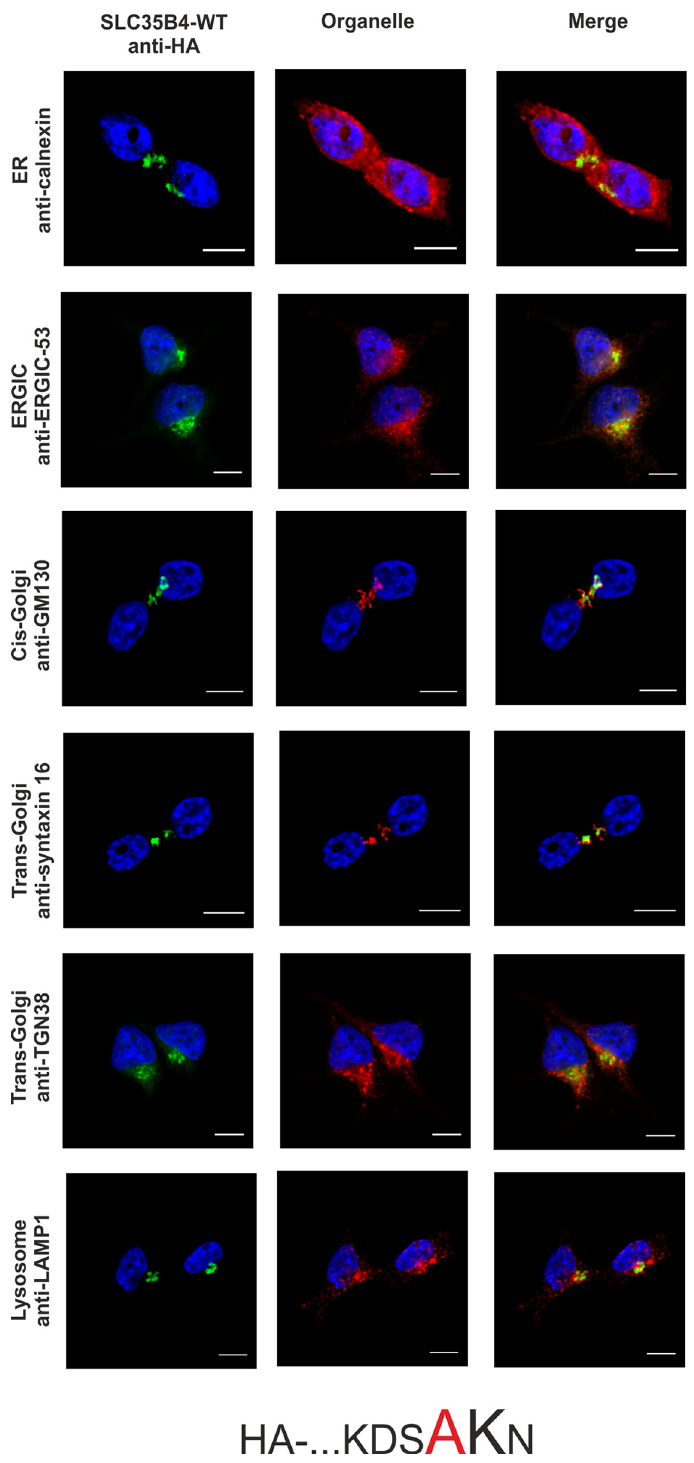
Fig 4. Subcellular localization of HA- ... KDSAKN, human SLC35B4 K329A with HA-epitope at the N-terminus in the wild-type HepG2 cells. Stably transfected wild-type (SLC35B4-WT) cells, overexpressing SLC35B4 variants, were subjected to indirect immunofluorescent staining with anti-HA (green) and anti-organelle markers (Table 3) (red) antibodies. Cell nuclei were counterstained with DAPI. Scale bar 10 μ m.